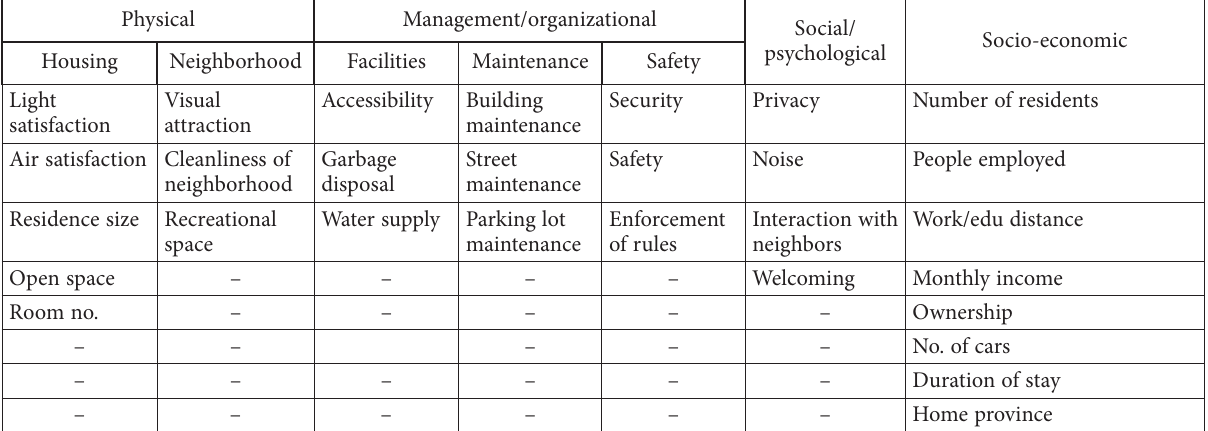
Table 1. Indicators of residential satisfaction and socio-economic profile of residents (Amérigo & Aragonés, 1988, 1990; Aragonés, Corraliza, Cortés, & Amérigo, 1992; Azimi & Esmaeilzadeh, 2017; Coker, Awokola, Olomolaiye, & Booth, 2008; Jaafar, Mohamad, Liza Hasan, & Ramayah, 2005; Marans, 2003)